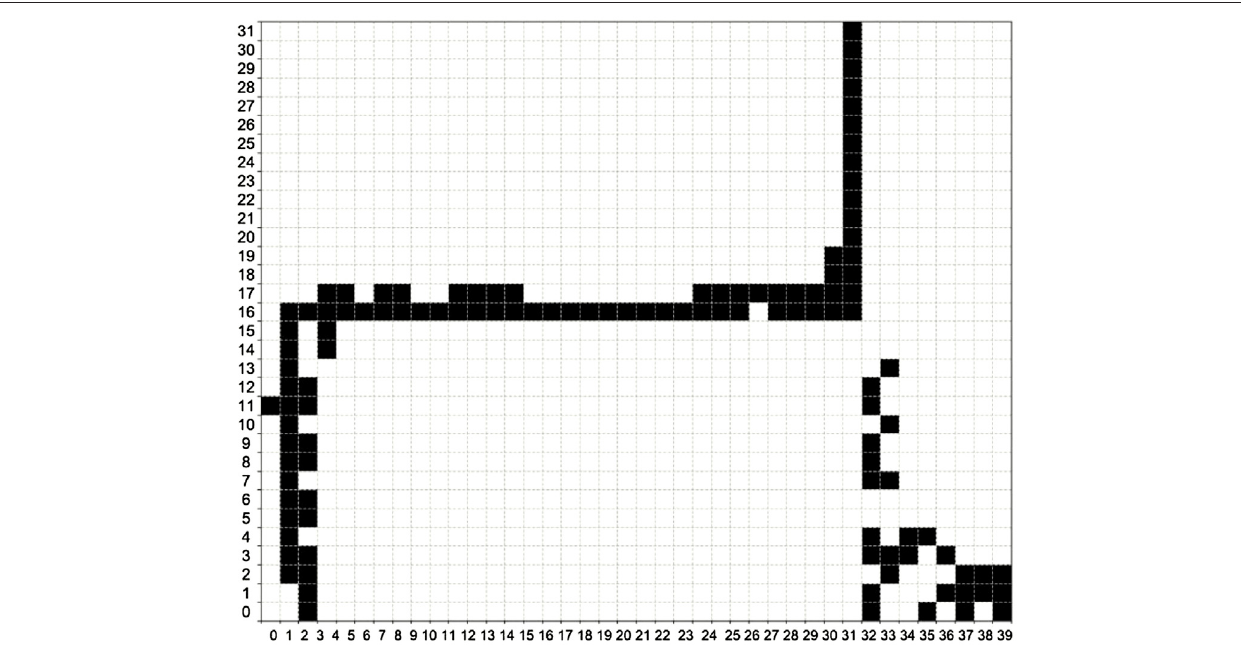
FIGURE 8 | Hybrid feature bitmap of electric bicycles.